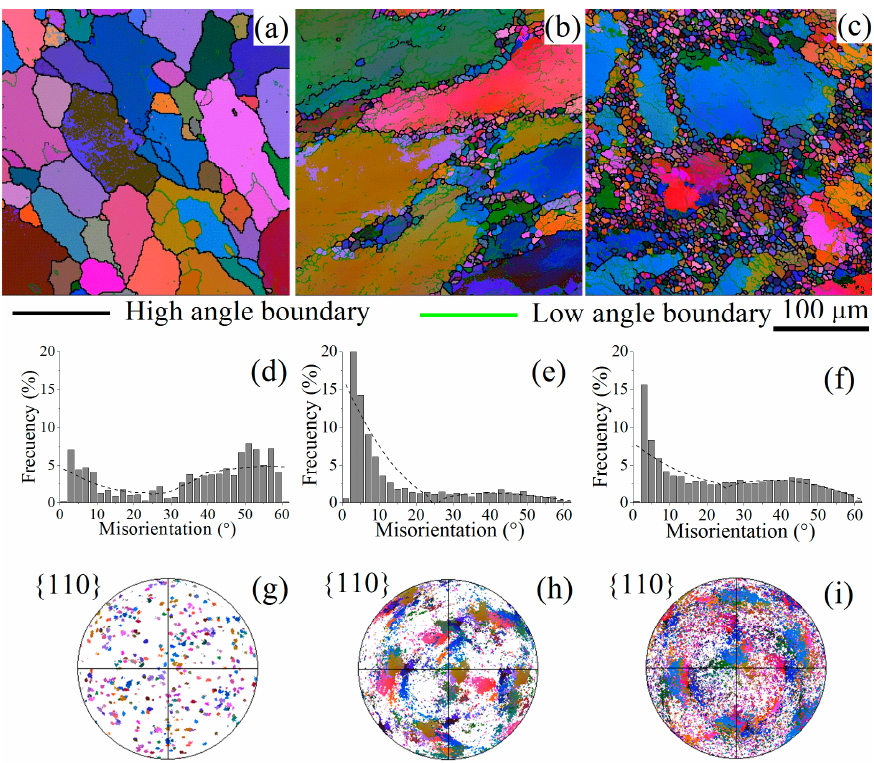
Figure 7. Grain distribution maps ( a – c ), boundary misorientation angle distributions ( d – f ), and the pole figures ( g – i ): as-homogenized ( a , d , g ); after two cycles ( b , e , h ); and after four cycles of forging at 400 ◦ C ( c , f , i ).